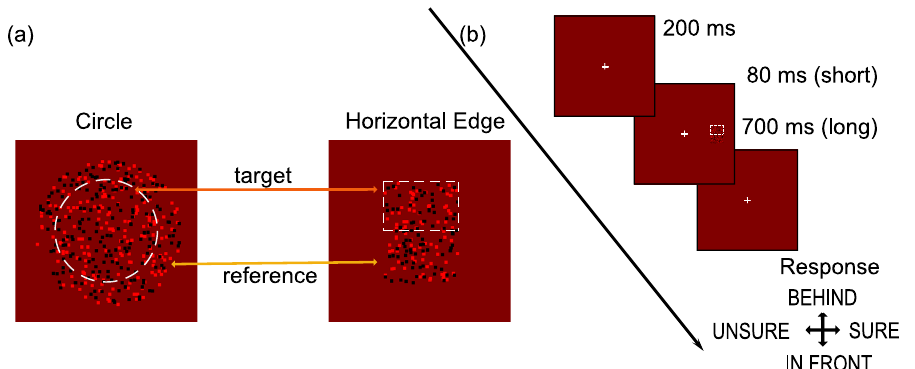
Fig 4. (a) Schematic of stimuli used for the Circle (left) and Horizontal Edge (right) conditions. For the circle condition the reference was the outside circle and for the horizontal edge condition the reference was always the bottom rectangle. The reference was always zero-disparity and the target disparity was 0 or ± 28 arc minutes (where negative values are for uncrossed ‘further away’ and positive values are for crossed ‘closer’ targets). (b) Procedure: Targets (Circle or Horizontal Edge) were presented at one of 5 eccentricities (0˚, 3.1˚, 6.2˚, 9.5˚ or 12.7˚) for either 80ms or 700ms. Participants reported the position of the target (compared to the reference) making a response using the up arrow for a ‘further way’ or down arrow for a ‘closer’ response. This was immediately followed by a confidence judgment where right arrow was selected for ‘high confidence’, or left arrow for ‘low confidence/guessed’.